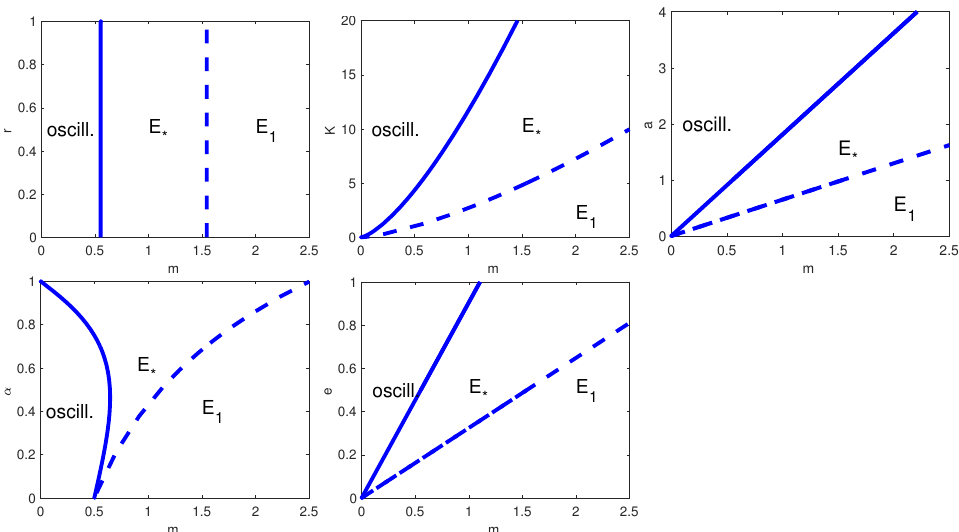
Figure 2. Two-parameter bifurcation diagrams with respect to m and, from top-left to bottom-right , r , K , a , α and e . Thick line: HB curve; dashed line: transcritical bifurcation curve. E ∗ is the coexistence equilibrium and E 1 the prey-only equilibrium. The remaining parameter values are as in Table